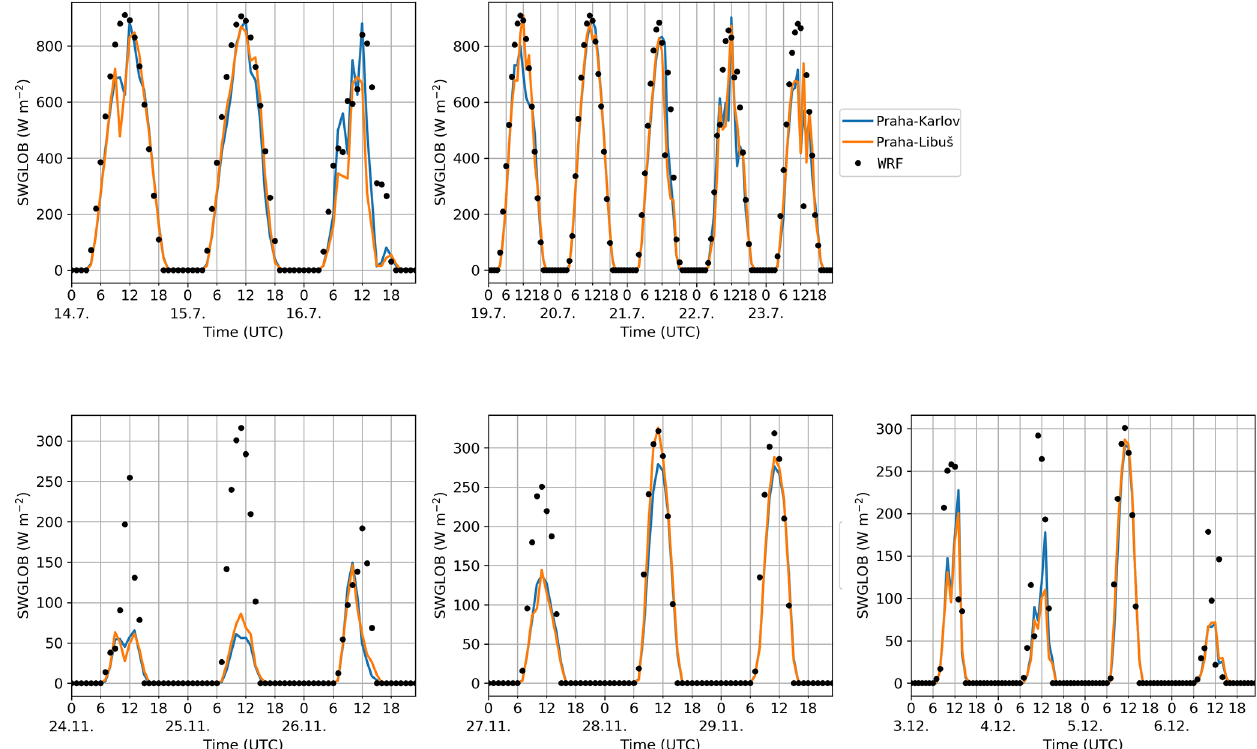
Figure 7. WRF modelled and observed downwelling SW radiation for the summer e1 and e2 (top row) and winter e1, e2, and e3 (bottom row) modelling episodes: CHMI station Praha-Karlov (blue line); CHMI station Praha-Libuš (orange line); WRF simulation (black